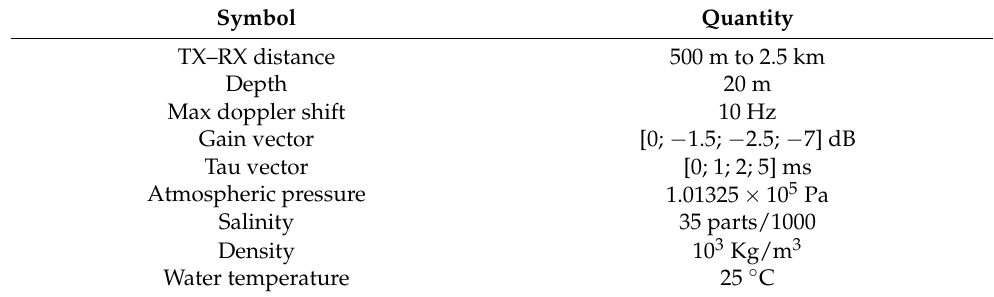
Table 2. Channel